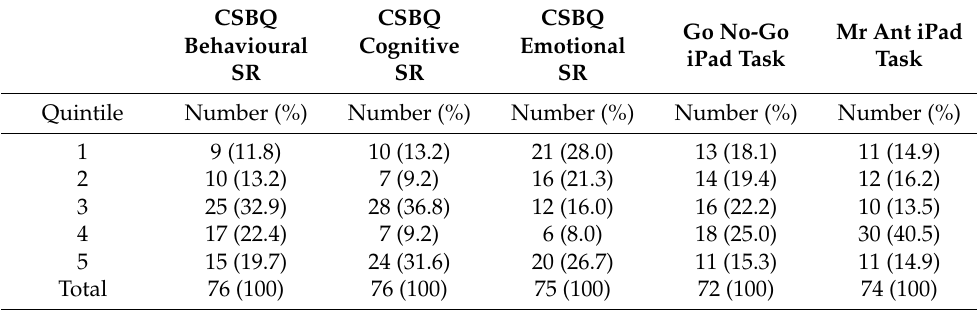
Table 3. Children’s performance of Early Years Toolbox tasks at